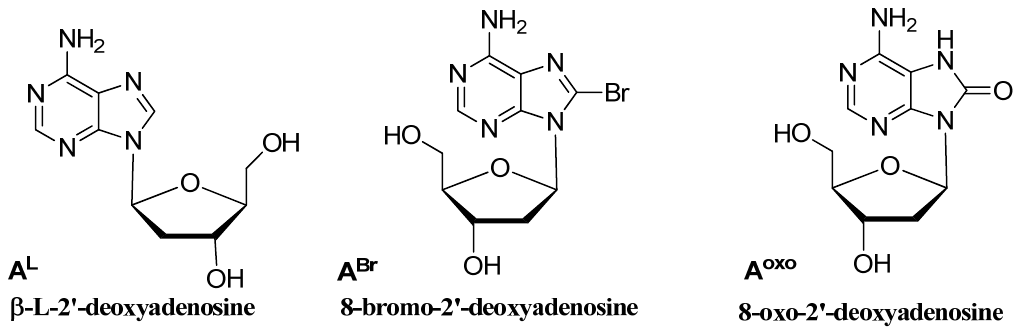
Figure 2. Chemical structures of the adenosine derivatives introduced in different loop positions of HT21.